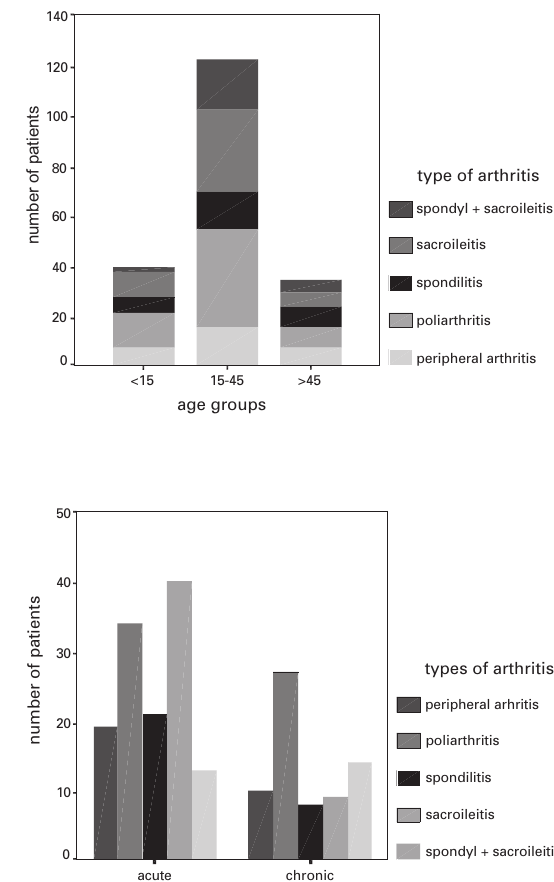
Figure 2 Types of arthritis in 195 patients with musculoskeletal involvement according to age groups.